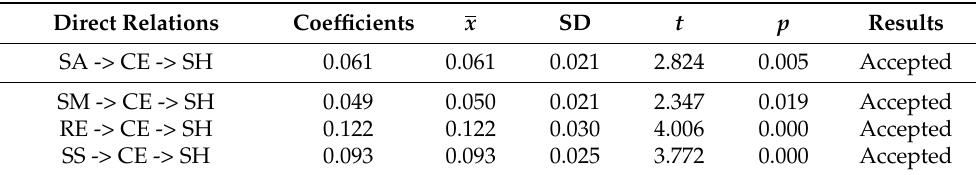
Table 8. Direct relationships.